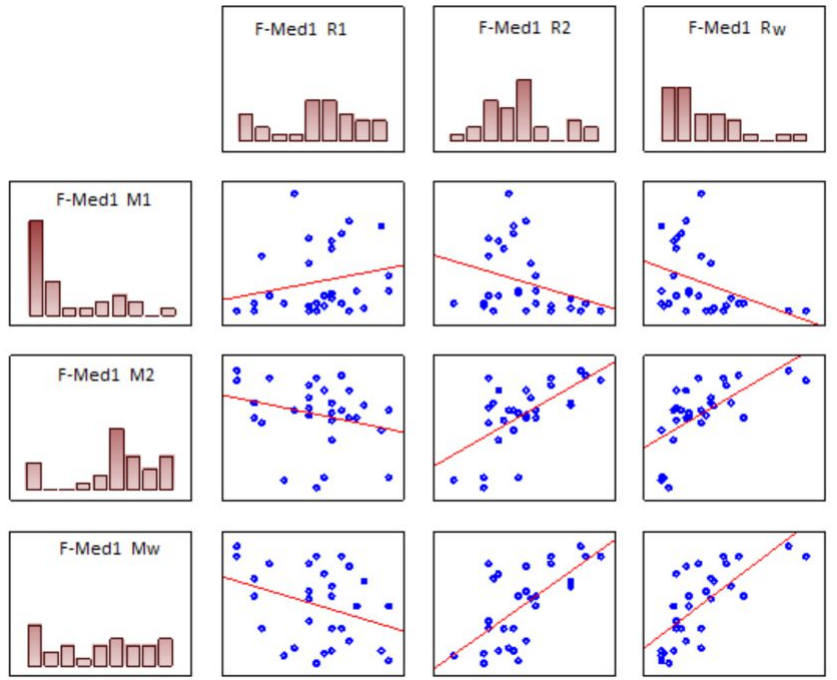
Figure 5. Selected correlations between the Moreland and the Rayleigh tests for the F-Med1 filter. Detailed correlations are listed in Table 5. Notice the particularly strong correlation between R W and M 1 (negative), as well as M 2 and M W (positive). Efficient perception of color shades in the lemon-orange range in the Rayleigh test was strongly correlated with efficient perception of shades in the blue-cyan-green axis. Such effect is best visible following the reduction of the amount of blue light with the F-Med1 filter (down to approx. 16%).